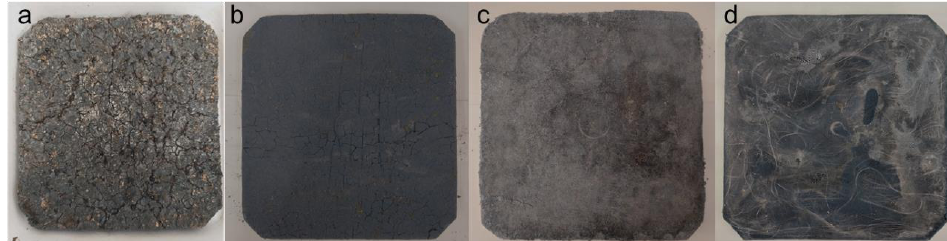
Figure 3. Macro-photographs of the rubber-silica aerogel composite panels reinforced with ( a ) recycled tire textile fibers; ( b ) polyester fiber blanket; ( c ) silica fiber felt; and ( d ) glass Table 1 . Key properties of the new fiber-reinforced rubber-silica aerogels . Property